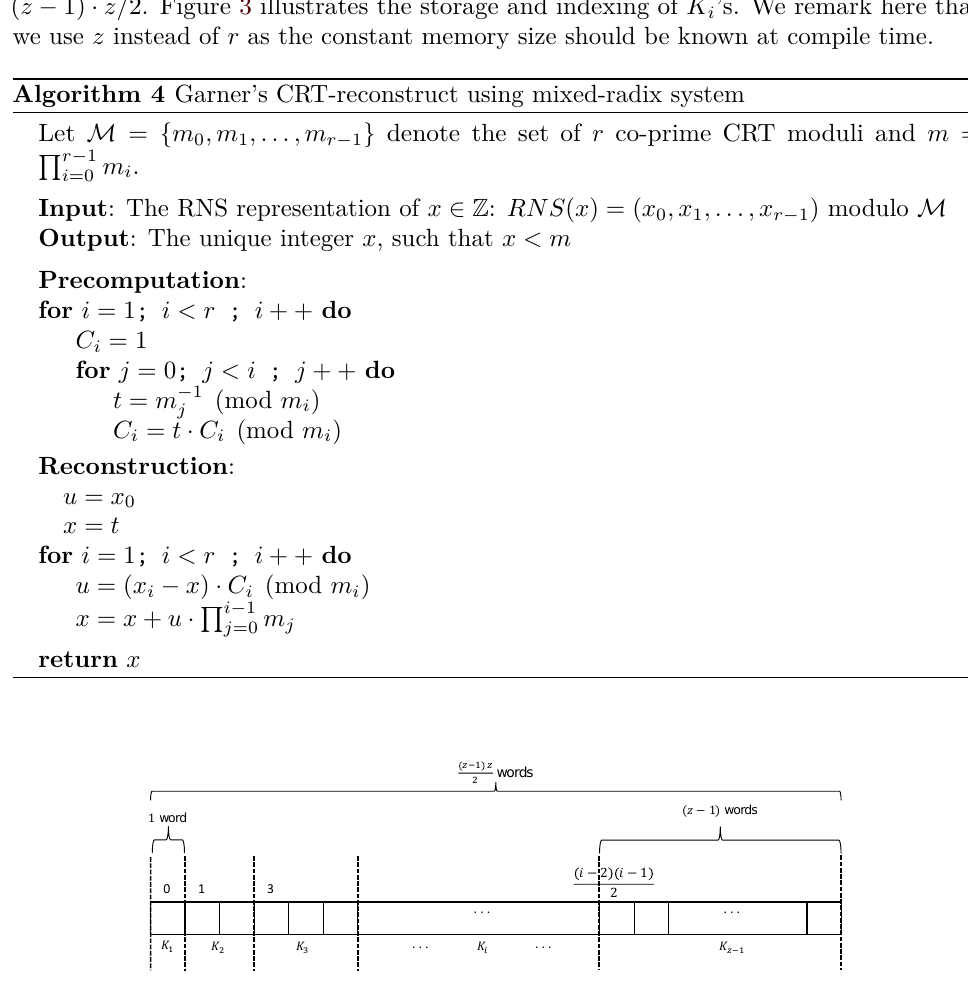
Figure 3: Memory layout of CRT products used in Garner’s CRT-reconstruct algorithm